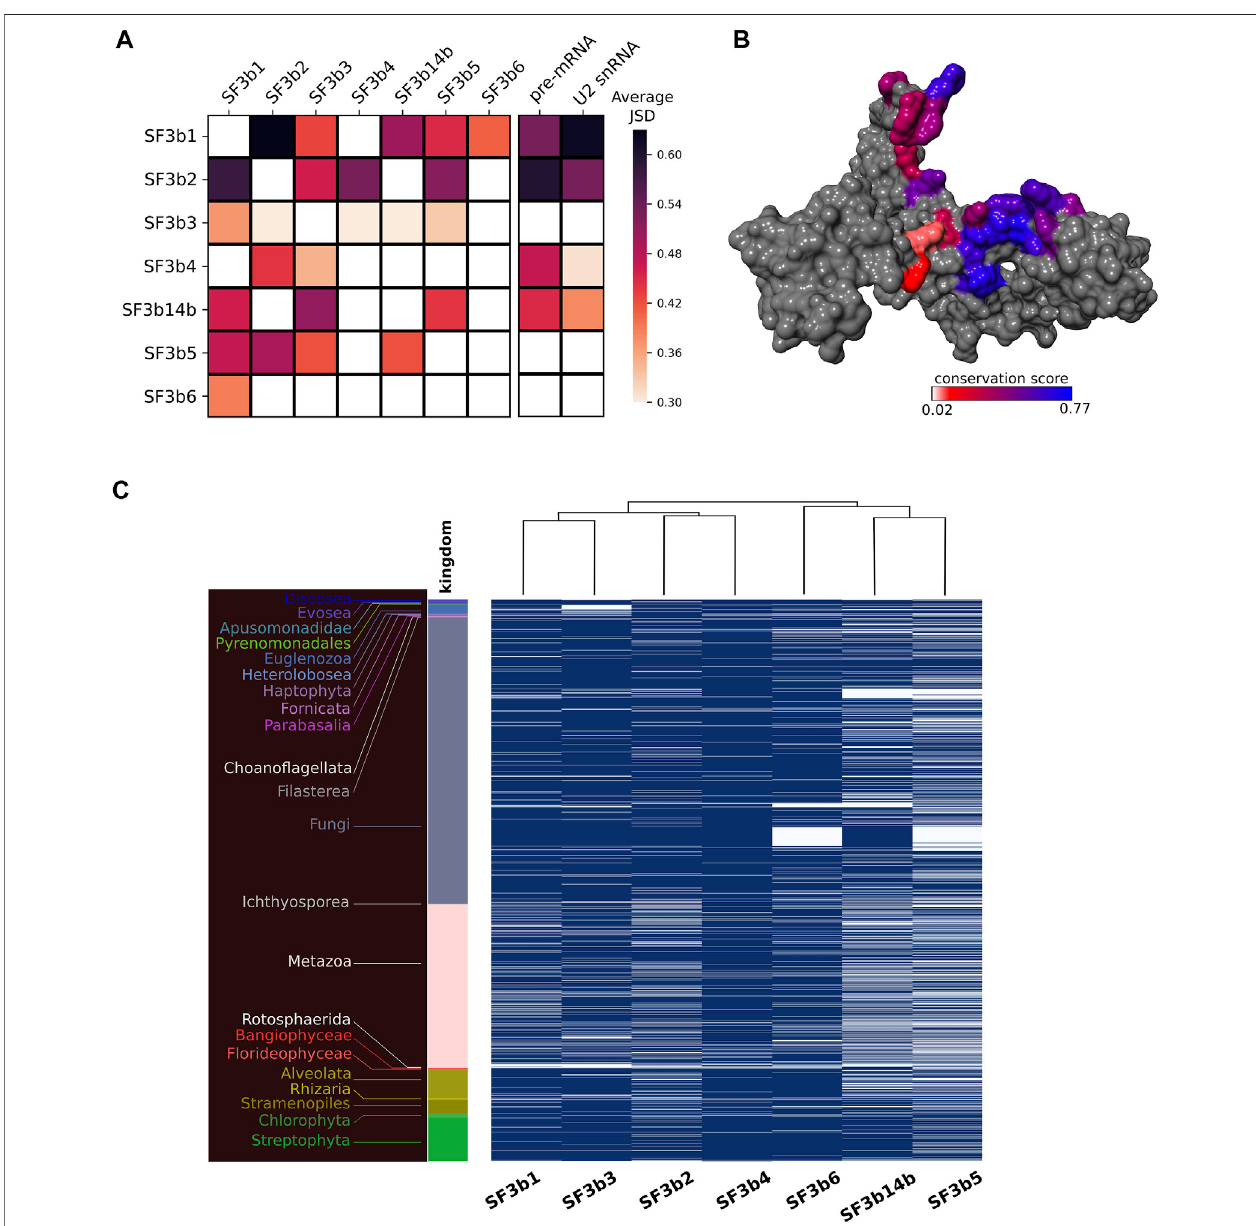
FIGURE 3 | Interface conservation in the SF3b complex. (A) Shown is the heatmap of average JSD scores for all the observed pairwise protein-protein/RNA interfaces. Row indicates the protein to which the concerned interface region belongs and column indicates the protein partner for that interface. (B) Surface representation of SF3b2 with interface region for SF3b3 is colored based on conservation (JSD) score. The color gradient indicates differential conservation of residues within an interface wherein blue depicts high residue conservation while red indicates poor residue conservation. (C) Shown is the heatmap to represent the presence (blue)/absence (white) of each SF3b protein in the eukaryotic species. The dendrogram at the top indicates different clusters of SF3b proteins based on the similarity in their phylogenetic distribution. For example, SF3b1 and SF3b3 that share similar pro fi les are grouped together as SF3b14b and SF3b5. The different color bars and corresponding labels to the left indicate species belonging to different